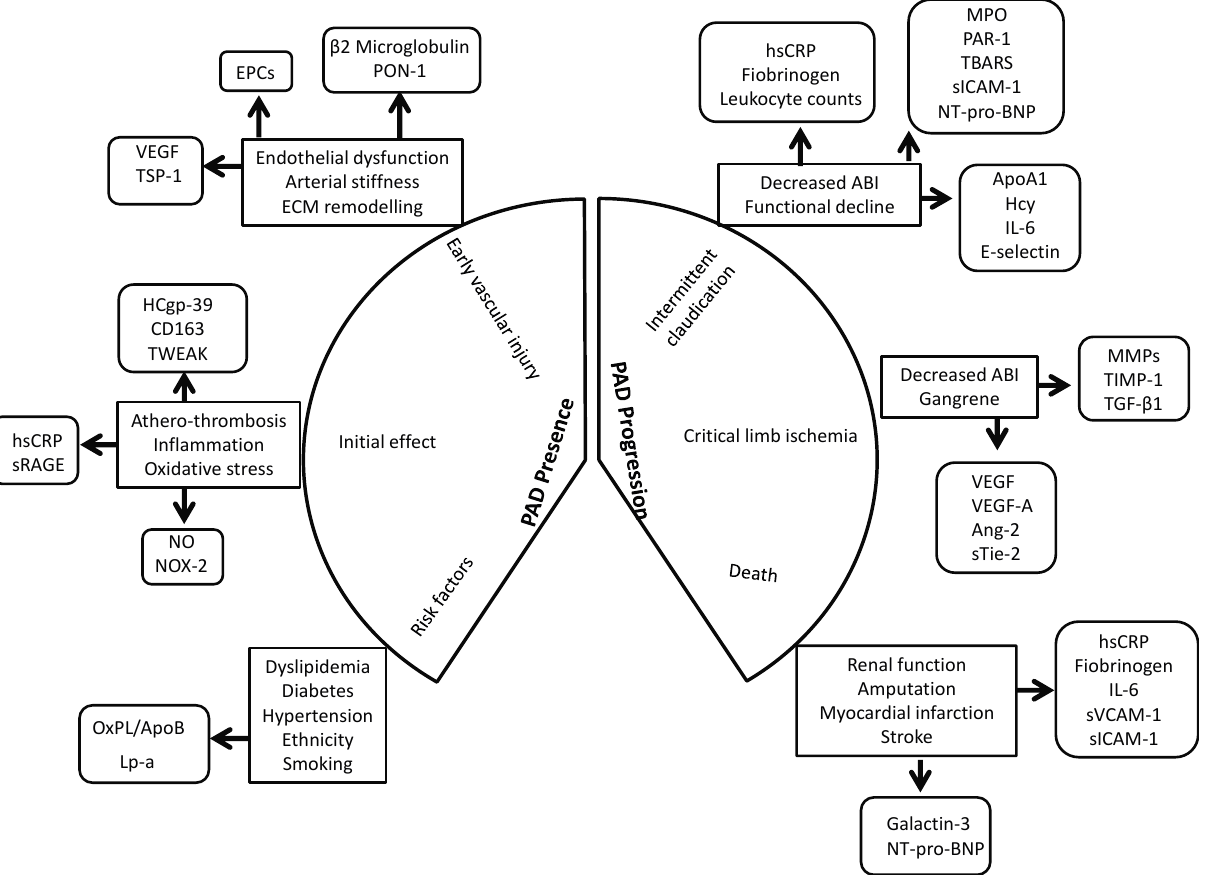
Figure 2. Circulating biomarkers in peripheral artery disease. A schematic depiction of the stages at which circulating biomarkers could be informative in the peripheral artery disease (PAD) course. Since PAD is multifactorial it is likely that a single biomarker may not be sufficient to predict diagnosis or prognosis. Since PAD development and progression is due to the interaction of multiple factors, it is possible that the combination of a number of biomarkers may be preferable to a single maker. Abbreviations: ABI, Ankle brachial index; Ang-2, Angiopoetin-2; ApoA1, Apolipoprotein A1; B2M, β -2-microglobulin; EPC, Endothelial progenitor cell; HCgp, Human cartilage glycoprotein; Hcy, Homocysteine; hsCRP, high sensitivity C-reactive protein; IL, Interleukin; Lp-a, Lipoprotein-1; MMP, Matrix mettalloprotenase; MPO, Myeloperoxidase; NO, Nitric oxide; NOX, NADPH Oxidase; NT-pro-BNP, N -terminal pro-B-type natriuretic peptide; OxPL/ApoB, Oxidised phospholipids on ApoB100 containing lipoproteins; PAD, Peripheral artery disease; PAR, Protease activated receptor; PON, Paraoxonase; sICAM-1, soluble Intercellular adhesion molecule-1; sRAGE, soluble receptor for advanced glycation end product; sTie-2, soluble Tyrosine kinase with immunoglobulin-like and EGF-like domains 2; sVCAM-1, soluble Vascular cell adhesion molecule-1; TBARS, Thiobarbituric acid-reactive substrates; TGF, Transforming growth factor; TWEAK, Tumour necrosis factor like weak inducer of apoptosis; TSP, Thrombospondin; TIMP, Tissue inhibitor of matrix metalloproteinase; VEGF, Vascular endothelial growth